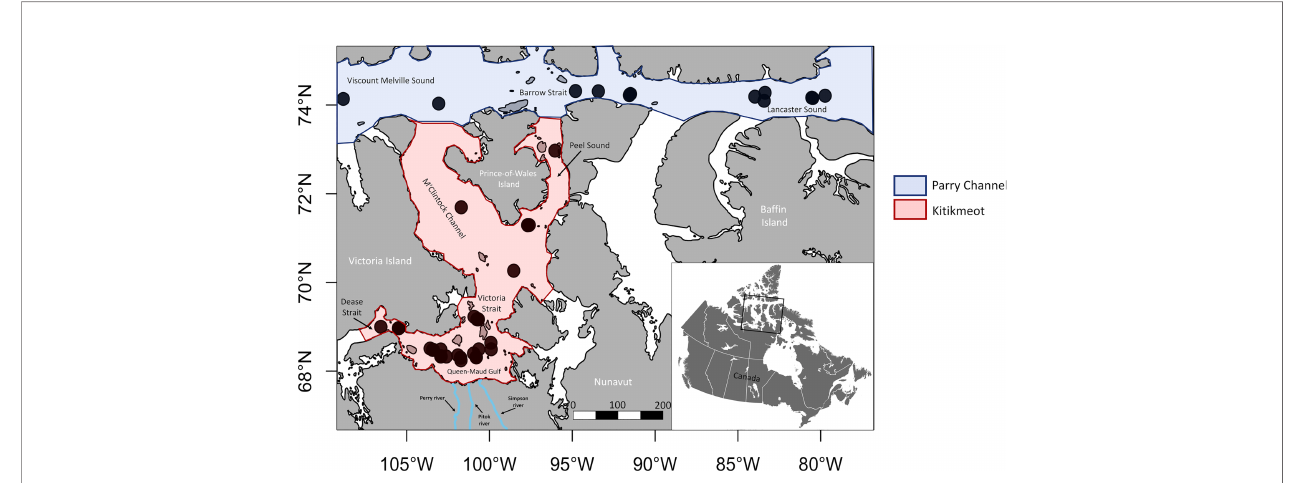
FIGURE 1 | Locations of epifauna, infauna and environmental variable sampling stations from Parry Channel and the Kitikmeot sea region. Note that the Kitikmeot Region also contains areas west (Coronation Gulf) and east (Chantry Inlet) of the marked area, but those were not